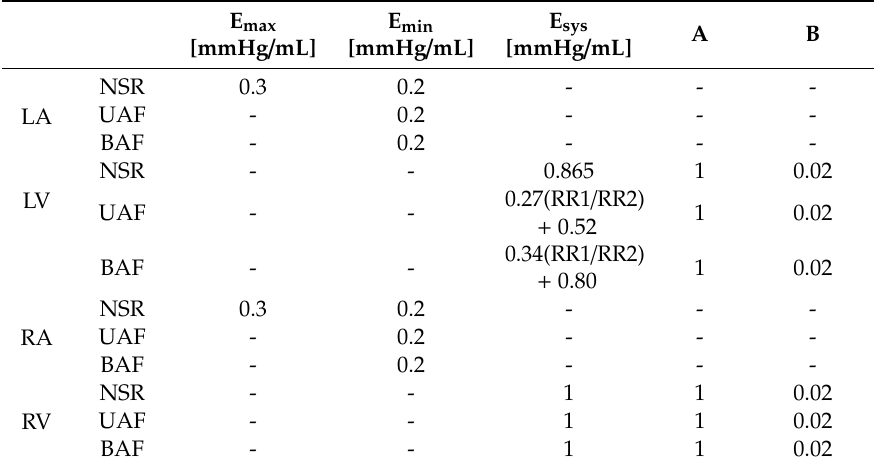
Table A3. Parameter values used in the atrial and ventricular models. LA , LV , RA and RV represent left atrium and ventricle and right atrium and ventricle, respectively, NSR , UAF and BAF represent normal sinus rhythm, unimodal atrial fibrillation and bimodal atrial fibrillation, respectively, E max , E min and E sys are the maximal and minimal elastances in atria and systolic elastance in ventricles, respectively, and A and B are coe ffi cients use in the model describing the passive component of the ventricular pressure